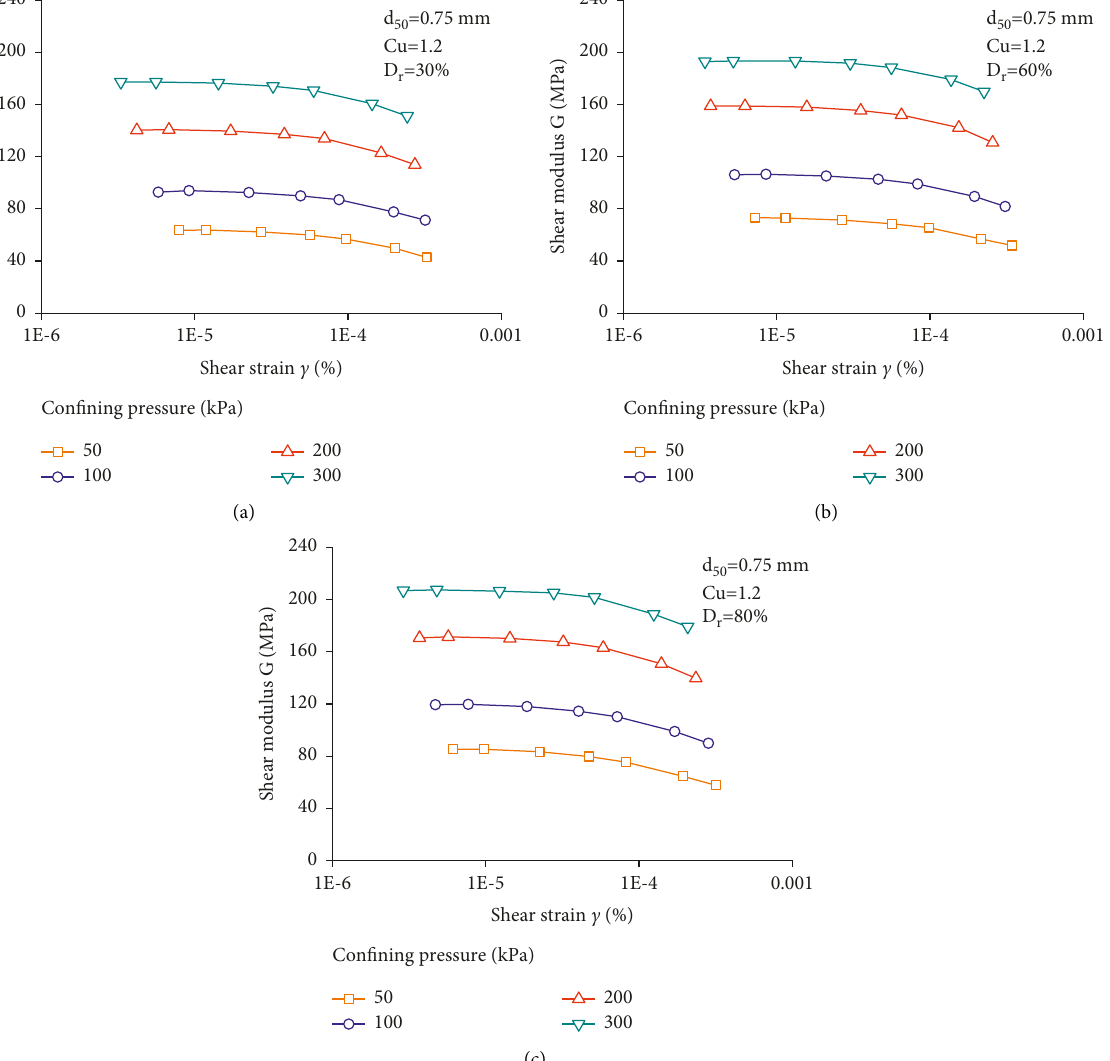
� 0.75 mm and Cu � 1.2 at different confining pressures. 50